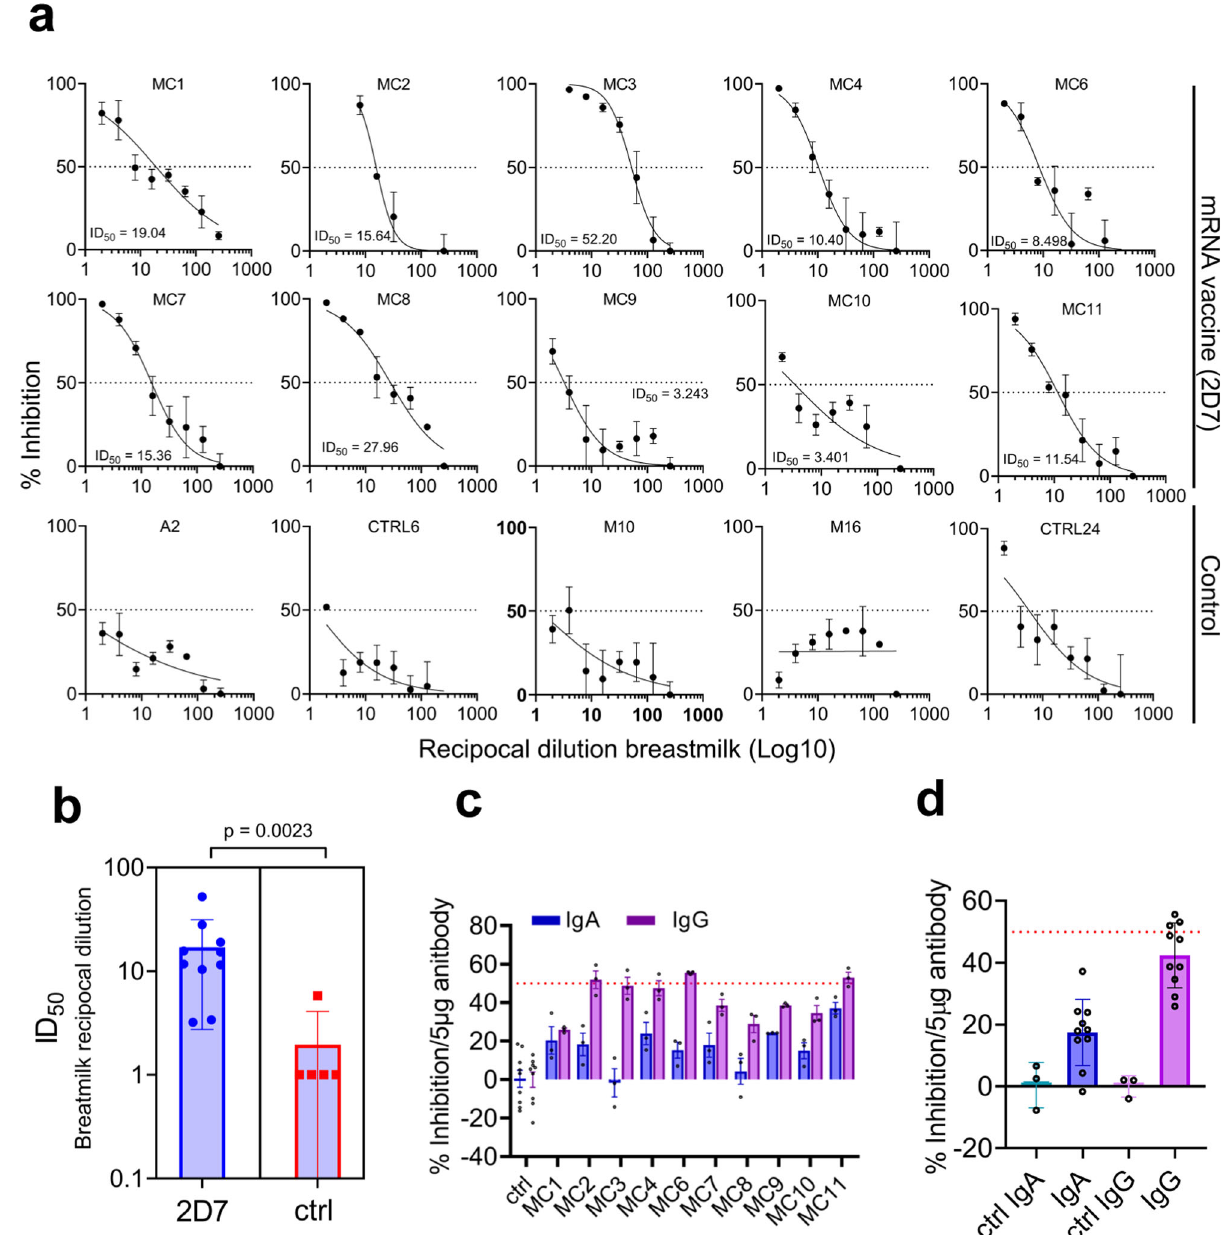
Fig. 3 Neutralization of breastmilk and puri fi ed breastmilk IgG and IgA. a SARS-CoV-2 spike bearing pseudovirus neutralization assay on serial dilutions of fi ltered mRNA-vaccine breastmilk samples collected at 2D7 ( n = 10) and of pre-pandemic breastmilk control samples ( n = 5). Breastmilk ID 50 is indicated in each plot as calculated by the nonlinear regression [inhibitor vs. response] model. Each measurement was carried out in triplicates. Mean and s.d. are indicated for each dilution. Mean and error bar for s.d. are indicated. b Comparison of ID 50 values of breastmilk from 2D7 ( n = 10) and control samples ( n = 5). P values were determined with an unpaired, two-sided Mann − Whitney U-test; P <0.05 was considered statistically signi fi cant. Mean and 95% CI are indicated. c Puri fi ed IgG and IgA from breastmilk collected at 2D7 ( n = 10) and pre-pandemic control samples ( n = 3) (concentration of 50 μ g/ml, 33nM, 13nM for IgG and IgA, respectively) were subjected to a spike-bearing pseudovirus neutralization assay; percent inhibition was calculated by measuring GFP-positive HEK-293 cells stably expressing hACE2. The number of GFP-positive cells was normalized and converted to a neutralization percentage. Each sample was measured in triplicate, and bar graph plots present mean values ± SEM. Precent inhibition was normalized per 5 μ g antibody. The horizontal dashed red line indicates 50% inhibition. d Bar plot summarizing the percent inhibition 2D7 breastmilk IgG and IgA ( n = 10) in comparison with IgG and IgA from pre-pandemic control samples. The horizontal dashed red line indicates 50% inhibition. Mean and 95% CI are indicated. Source data are provided as a Source Data fi